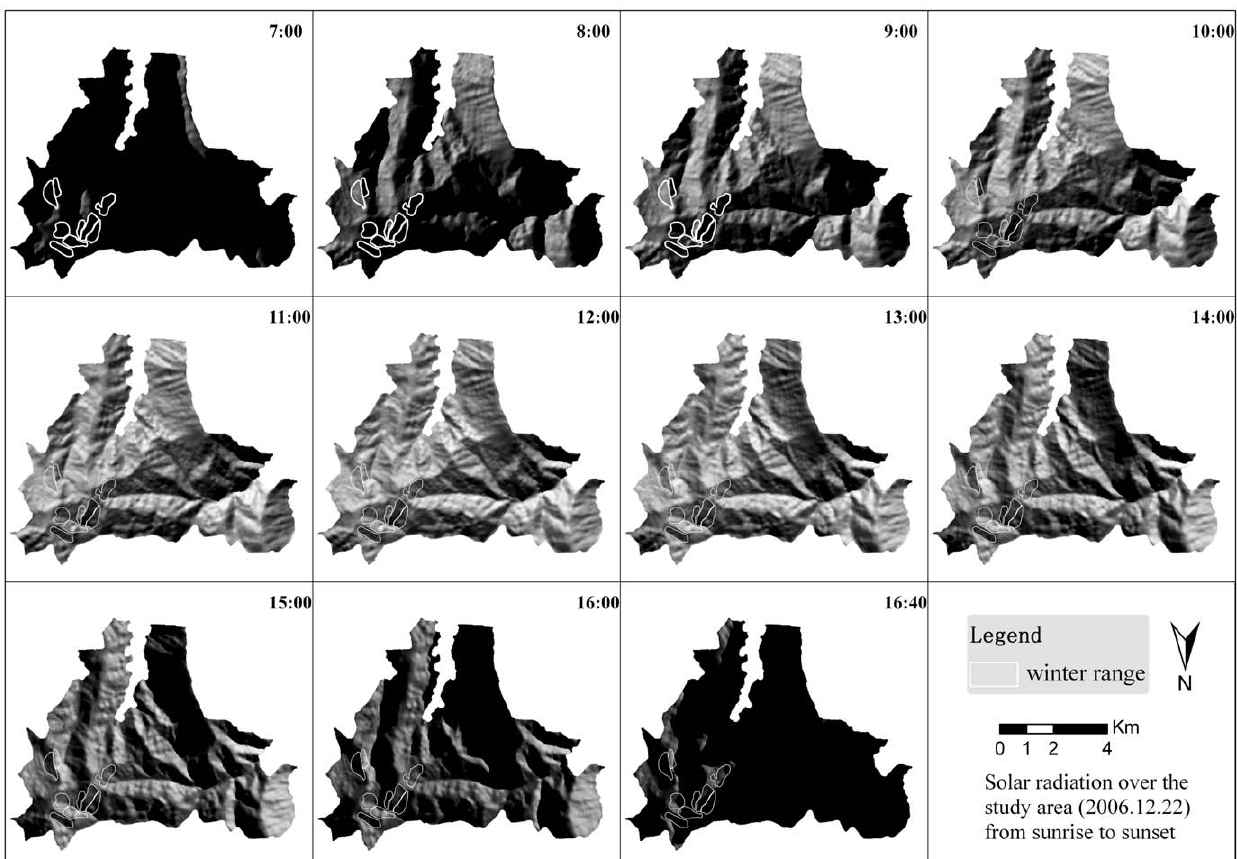
Figure 6. The pattern of solar illumination throughout the monkey’s entire home range (3500 to 4500 m) from sunrise (7:00 am) to nearly sunset (16:40 pm) on December 22, 2006. Areas with dark/light color indicate where there is no sun/sun exposure respectively. Higher elevation areas usually have a longer duration of sunlight (the sunlight both begins earlier and ends later in higher areas), indicated by light color.